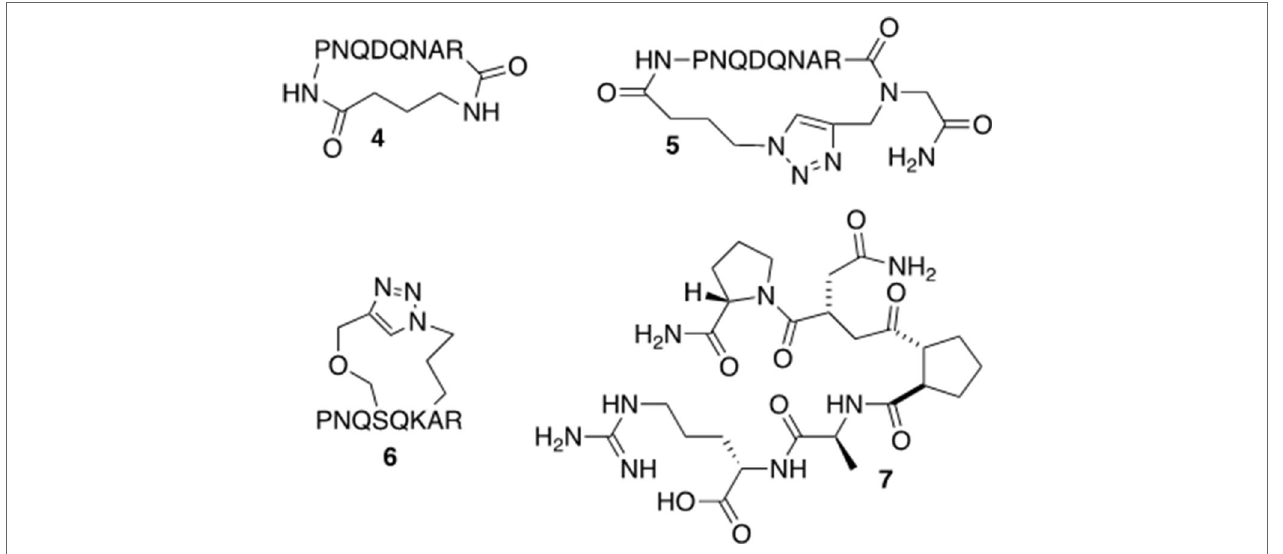
FIGURE 5 | Modified versions of peptide 2.